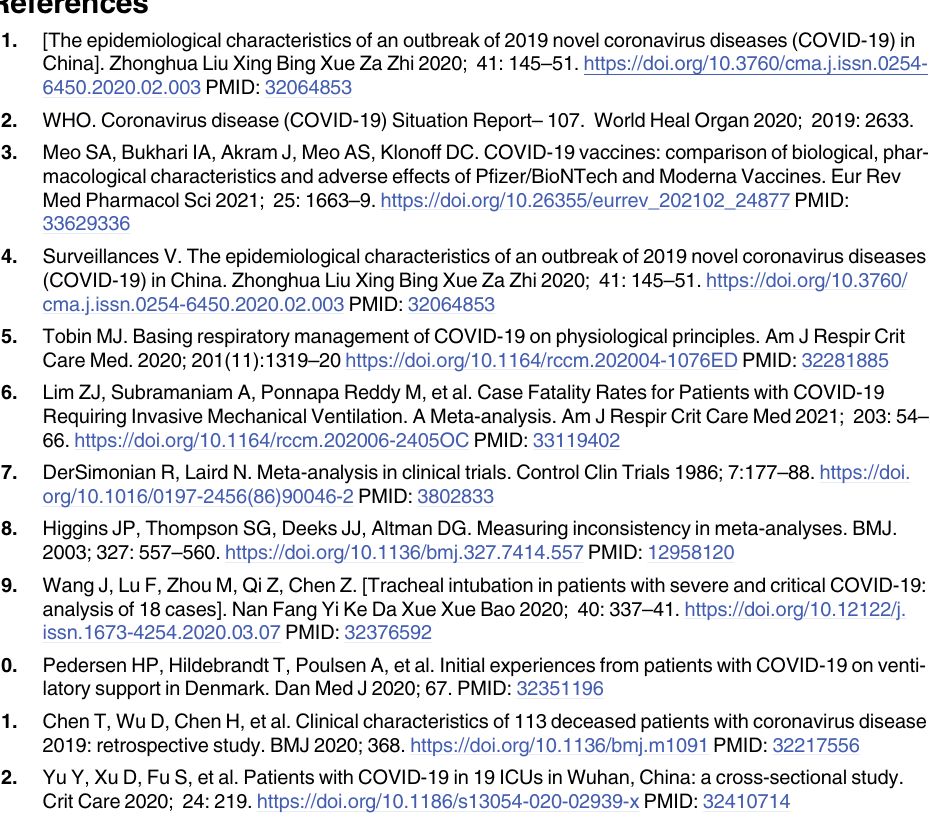
S1 Table. Quality of the included studies; NOS = Newcastle Ottawa